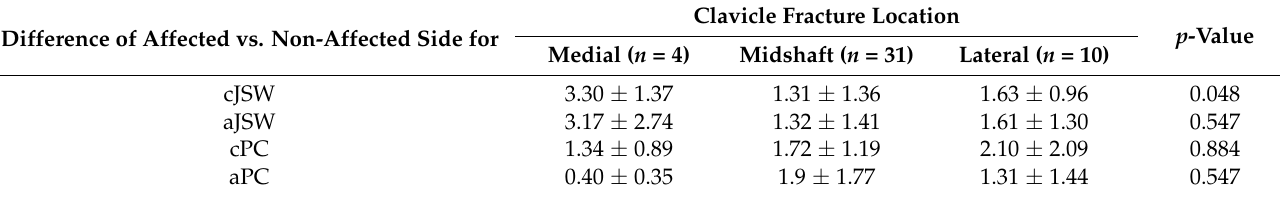
Table 3. Difference of affected vs. non-affected side for joint space width and position of the medial clavicle in relation to clavicle fracture